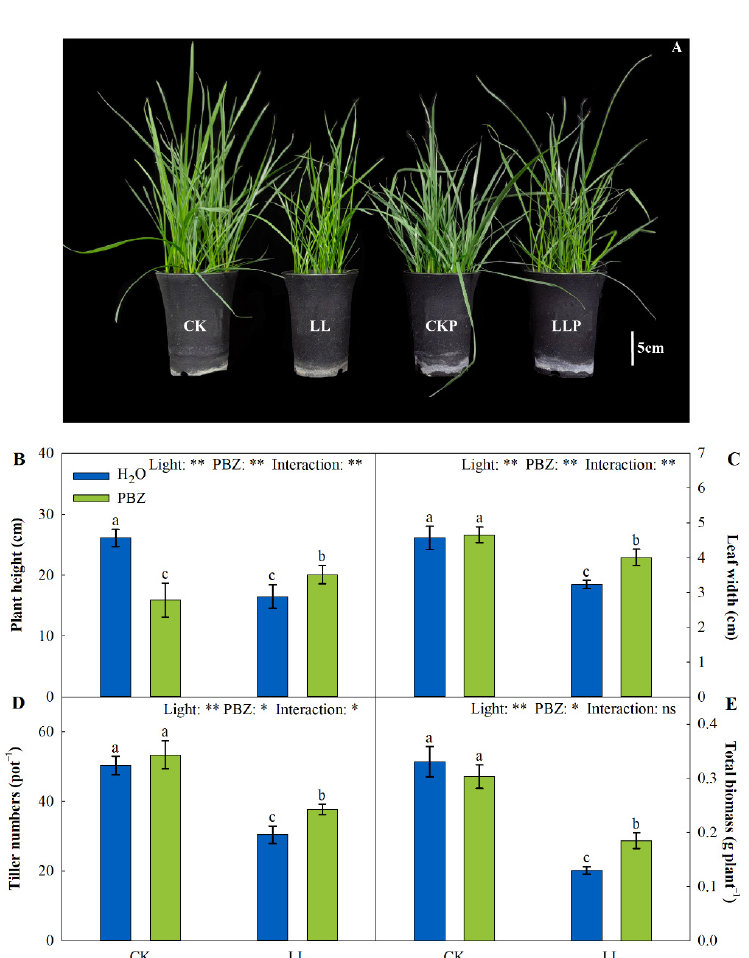
Figure 1. Effects of paclobutrazol on the morphology ( A ), plant height ( B ), leaf width ( C ), tiller numbers ( D ), and total biomass ( E ) of tall fescue under low-light (LL) stress. H 2 O and PBZ represent the treatments treated with distilled water and 200 mg L − 1 paclobutrazol under control (CK) or LL stress, respectively. The data are mean ± SD values (n = 3). * and ** indicate significant differences at p < 0.05 and p < 0.01, respectively. ns indicates not significant. Different letters above the vertical bars indicate significant differences at p < 0.05 according to Duncan’s multiple range test.